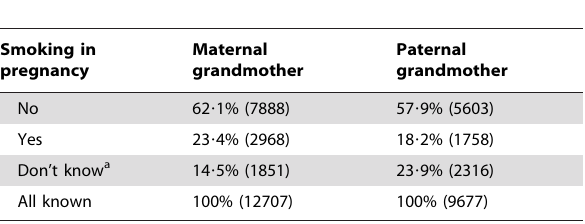
study parents’ birth.